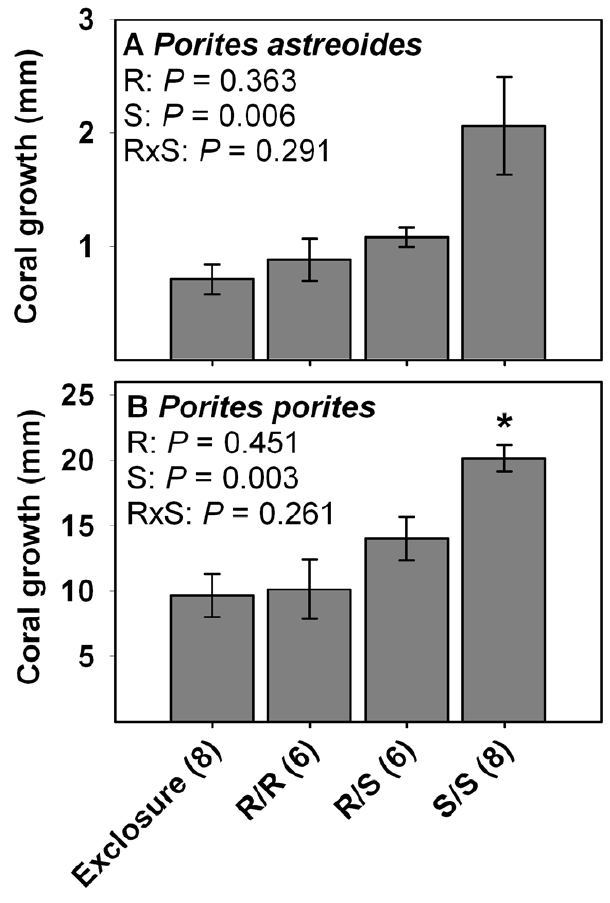
Figure 5. Skeletal growth (mean 6 SE) of corals at the end of Year 1. Data are for (A) Porites astreoides and (B) Porites porites. R = redband parrotfish and S = ocean surgeonfish. Statistics are from two- factor ANOVA. * indicates a single-herbivore treatment that differs from the mixed-herbivore treatment as determined via resampling statistics. Sample size is in parenthesis next to each treatment.